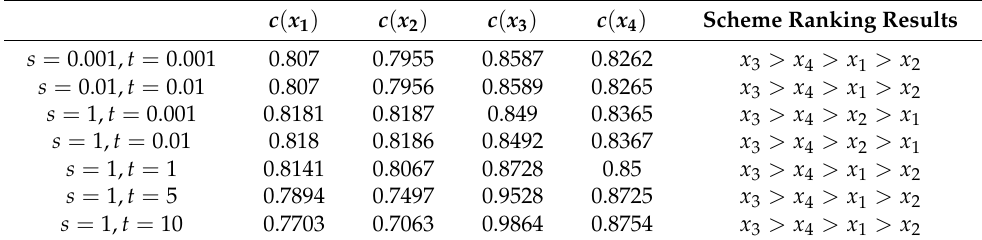
Table 2. Scheme ranking the results for different s and t values. c ( x 1 ) c ( x 2 ) c ( x 3 ) c ( x 4 ) Scheme Ranking Results s = 0.001, t = 0.001 0.807 x 3 > x 4 > x 1 > x 2 s = 0.01, t =